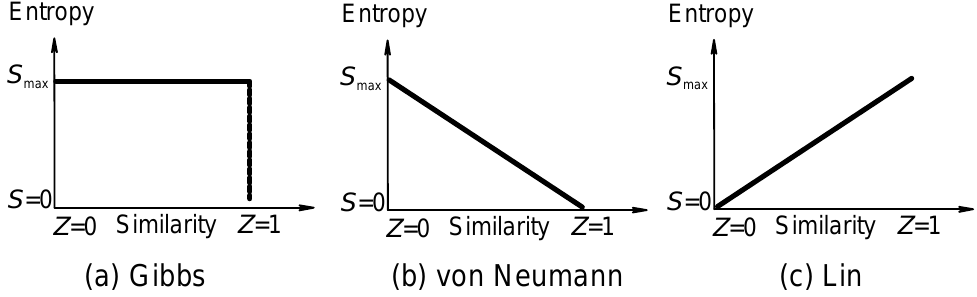
Figure 1. (a) Correlation of entropy (ordinate) of mixing with similarity (abscissa) according to conventional statistical physics, where entropy of mixing suddenly becomes zero if the components are indistinguishable according to the Gibbs paradox [21]. Entropy decreases discontinuously . Figure 1a expresses Gibbs paradox statement of "same or not the same" relation. (b) von Neumann revised the Gibbs paradox statement and argued that the entropy of mixing decreases continuously with the increase in the property similarity of the individual components [21a,21b,21d,21j]. (c) Entropy increases continuously according to the present author [7] (not necessarily a straight line because similarity can be defined in different